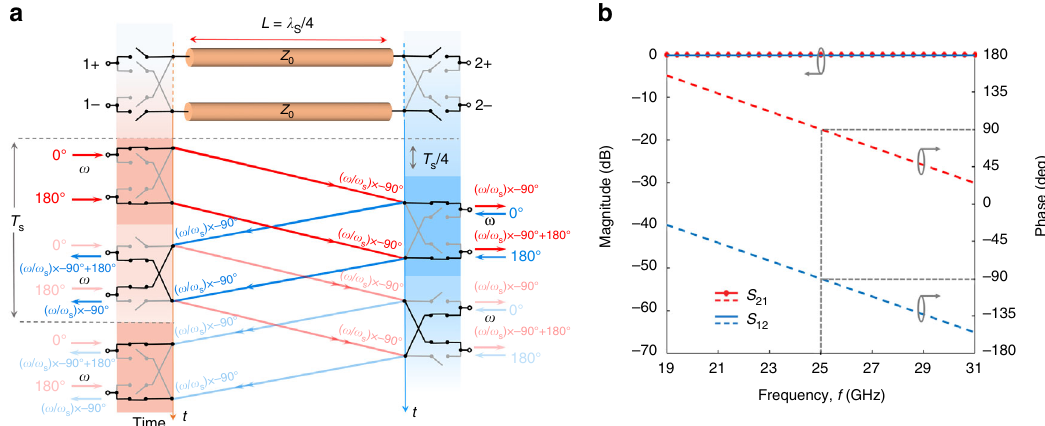
Fig. 3 In fi nite-bandwidth gyrator based on a balanced pair of delay lines with switches. a Schematic and operation diagram of the balanced in fi nite- bandwidth gyrator, consisting of a pair of transmission lines of characteristic impedance Z 0 (which is the same as the port impedance) and delay T s /4, sandwiched between ideal switch quads clocked at ω s with 50% duty cycle. A pair in the switch quads connects the balanced inputs and outputs to the transmission lines directly in one half cycle, and the crisscrossed pair performs a polarity inversion in the other half cycle. The switch quads on either side operate with quarter-period delay between them. This structure provides a non-reciprocal phase shift of π with zero insertion loss and perfect input/output matching (i.e., ideal gyrator operation) over all frequencies. b Scattering parameters for the case of f s = 8.33